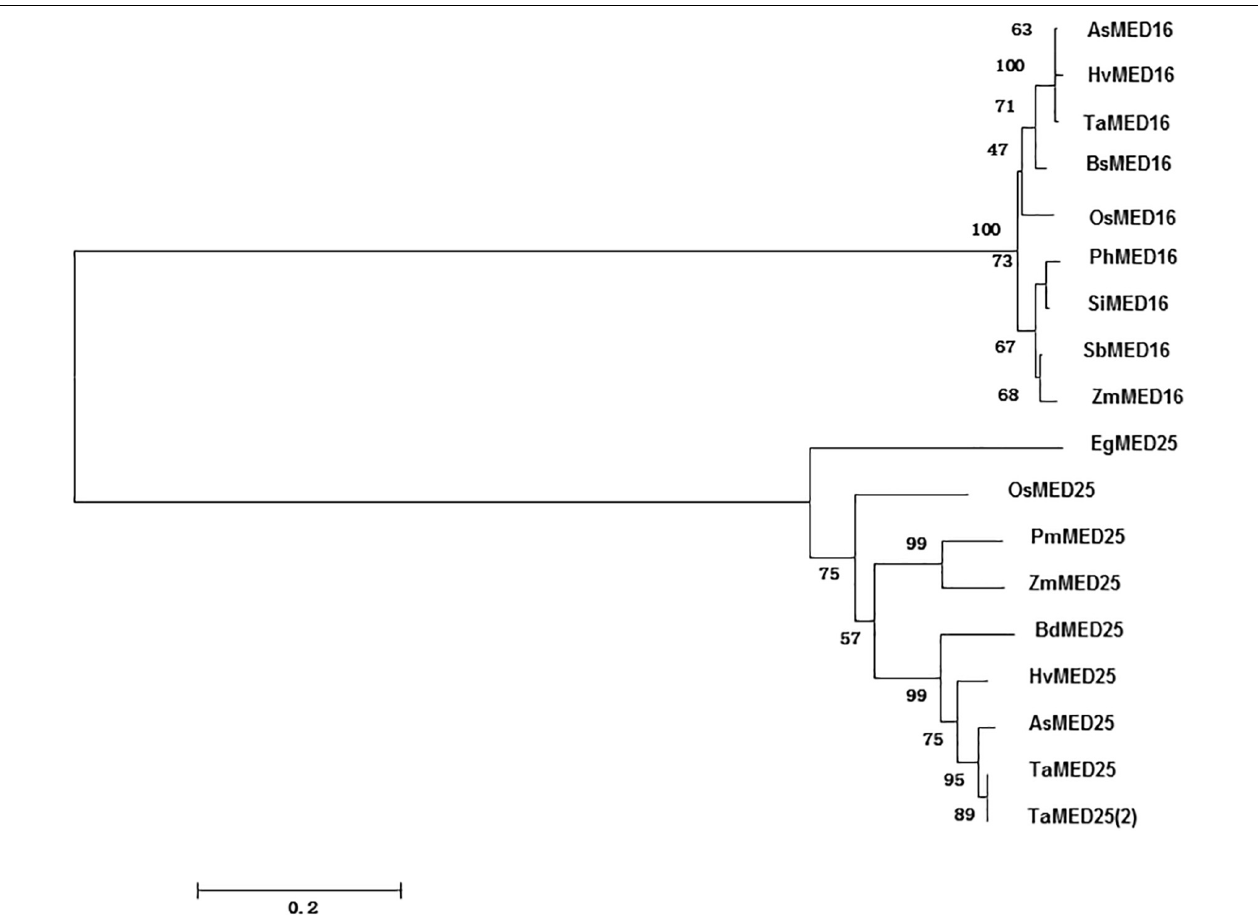
FIGURE 1 | Phylogenetic tree of OsMED16 and OsMED25. Phylogenetic tree was constructed by neighbor-joining method using MEGA program version 6.0.